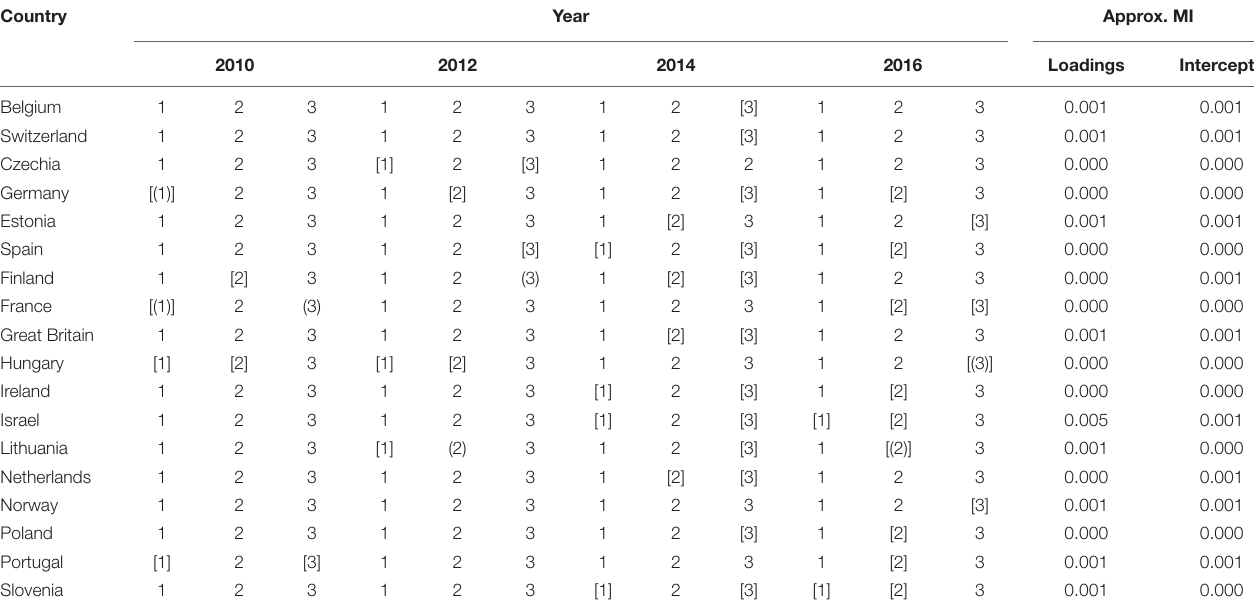
TABLE 1 | Invariance analysis of the opposition to migration index. Country Year Approx. MI